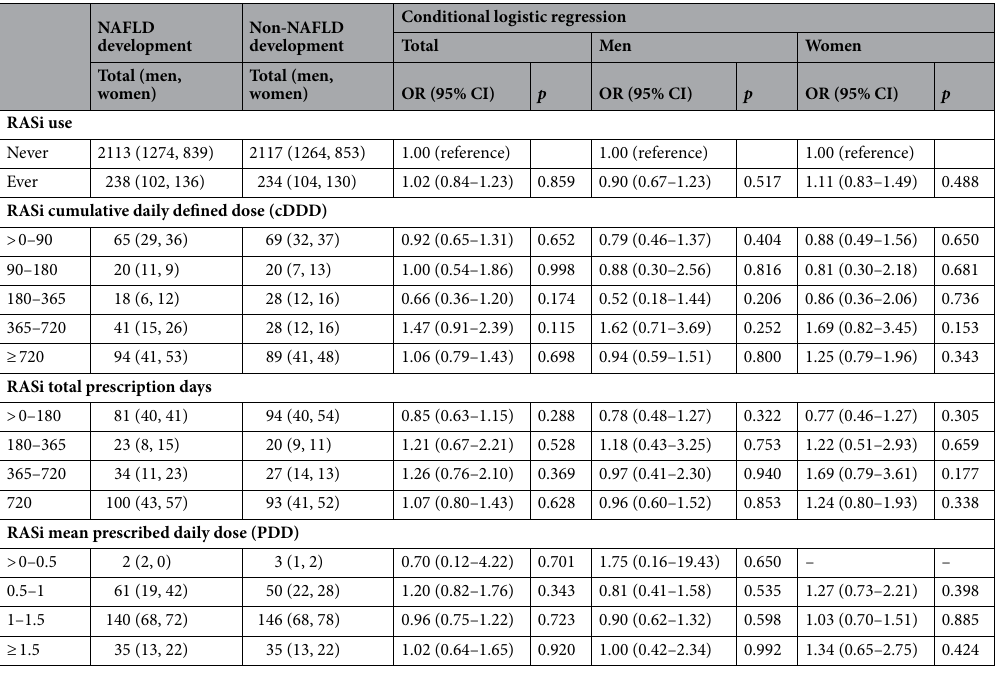
Table 2. Risk of NAFLD development according to the RASi exposures. CI confidence interval, NAFLD non- alcoholic fatty liver disease, OR odds ratio, RASi renin–angiotensin–aldosterone system inhibitors.